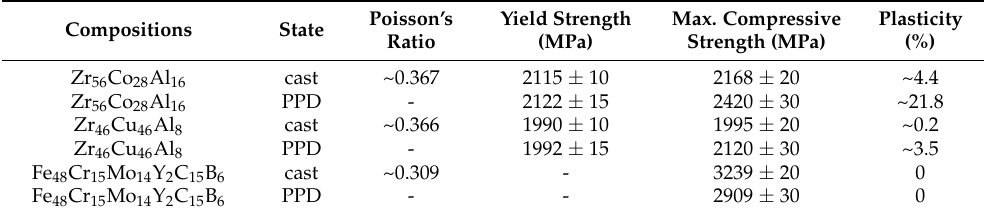
Figure 3. Engineering stress-strain curves under compression: ( a ) Zr 56 Co 28 Al 16 , ( b ) Zr 46 Cu 46 Al 8 , and ( c ) Fe 48 Cr 15 Mo 14 Y 2 C 15 B 6 BMGs in the as-cast state and after PPD treatments. Table 1. Poisson’s ratio, yield strength, and plasticity of Zr 56 Co 28 Al 16 , Zr 46 Cu 46 Al 8 , and Fe 48 Cr 15 Mo 14 Y 2 C 15 B 6 BMGs in the as-cast state and after PPD